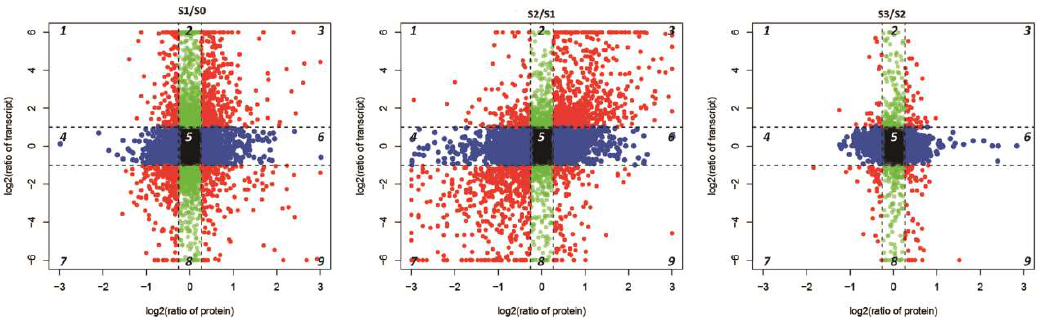
Figure 7. Comparison of changes in protein and cognate mRNA abundance levels. The relative changes in abundance (S1/S0, S2/S1 and S3/S2) are shown using a log2 scale. The associate protein: mRNA were divided into 9 types using 9 quadrants and several colors, respectively representing the differential expression trend of protein: mRNA. The center of the black plot was marked as quadrant 5, where protein and mRNA levels did not vary above 1.2- and 2- fold, respectively. The red dots in quadrants 3 and 7, representing a positive correlation between protein abundance and transcript accumulation in different stage. The red dots in quadrants 1 and 9 show negative correlations. Green dots in quadrants 2 and 8 indicate no difference in protein expression, while transcriptional expression tends to be up-regulated or down-regulated. Blue dots in quadrants 4 and 6 show differences in protein expression, while transcriptional expression tends to be no significant difference.